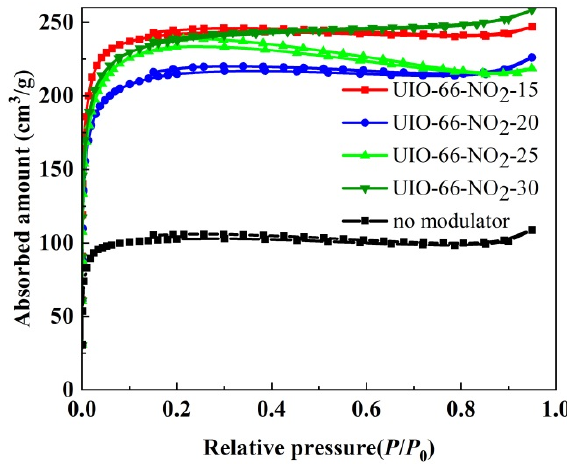
Figure 4. Nitrogen adsorption–desorption isotherms of UiO-66-NO 2 -X. Table 3. Analysis of nitrogen adsorption isotherms of UiO-66-NO 2 -X. Entry